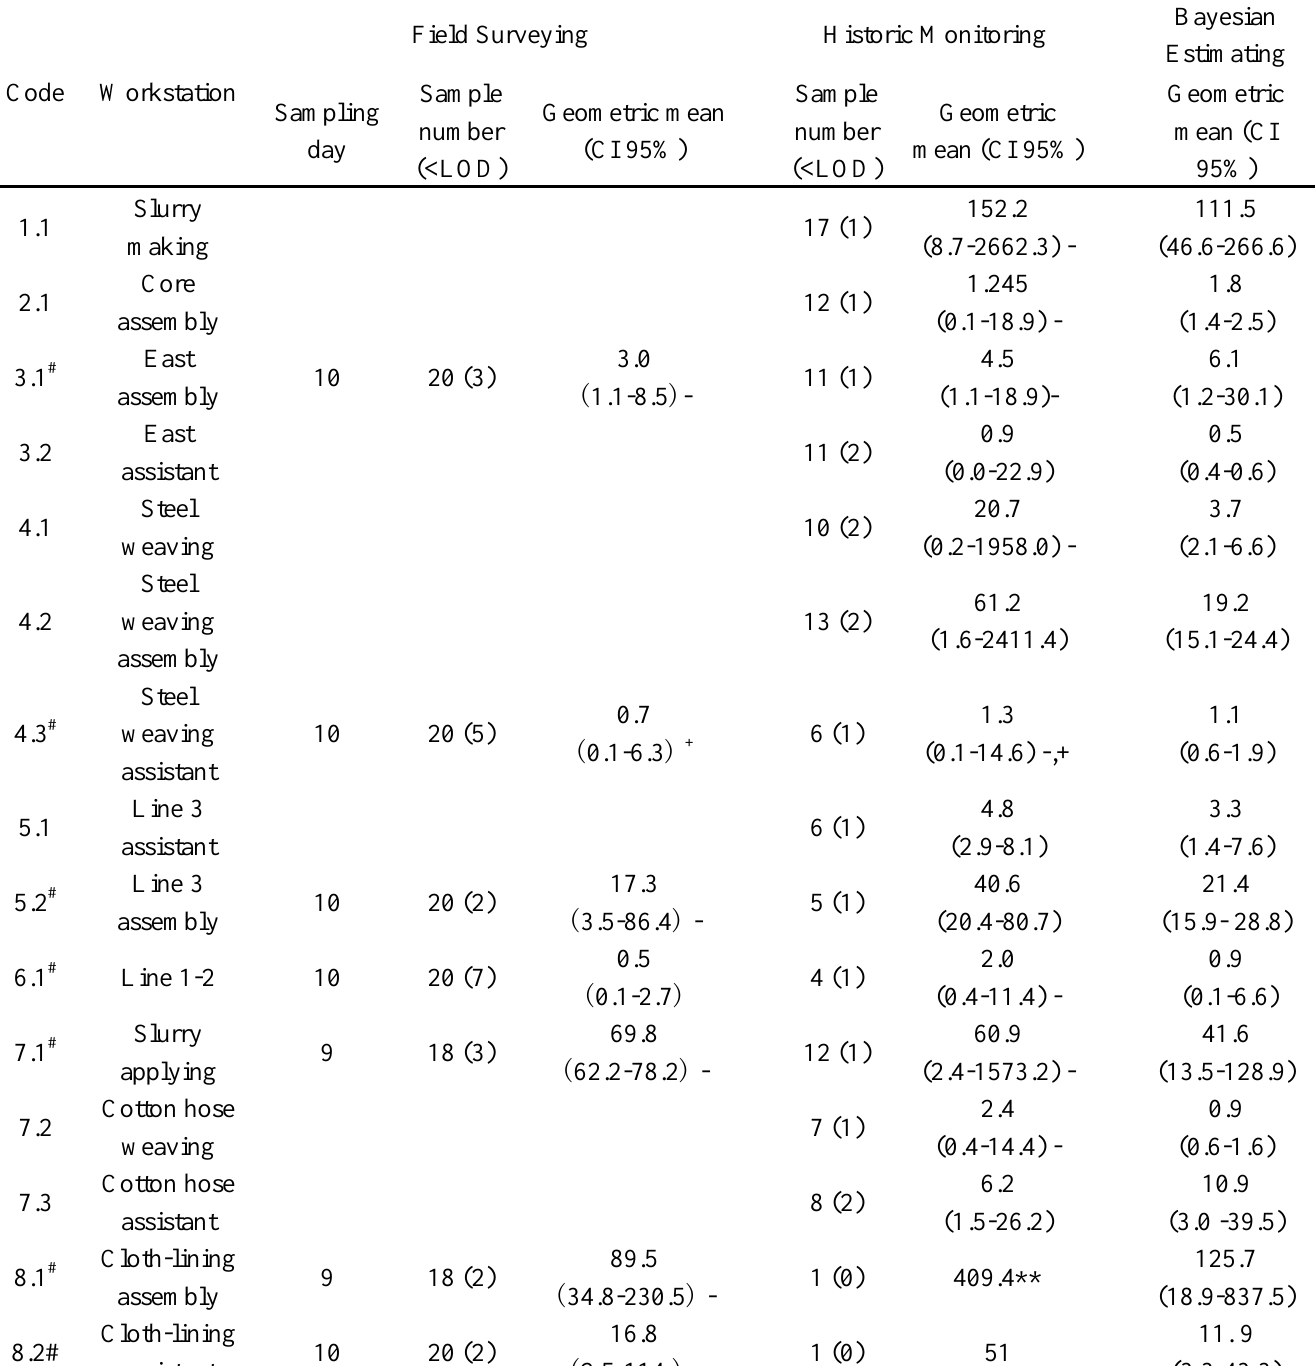
Table 4. Area concentrations (CI 95%, mg/m 3 ) of airborne benzene by field surveying, historic monitoring and Bayesian